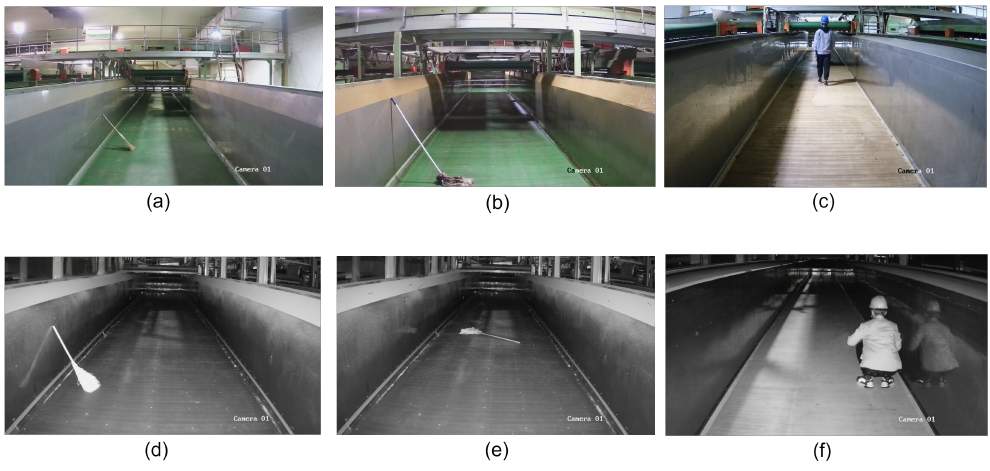
Figure 1. Foreign object data. ( a ) Broom (RGB image). ( b ) Mop (RGB image). ( c ) Human (RGB image). ( d ) Broom (gray image). ( e ) Mop (gray image). ( f ) Human (gray